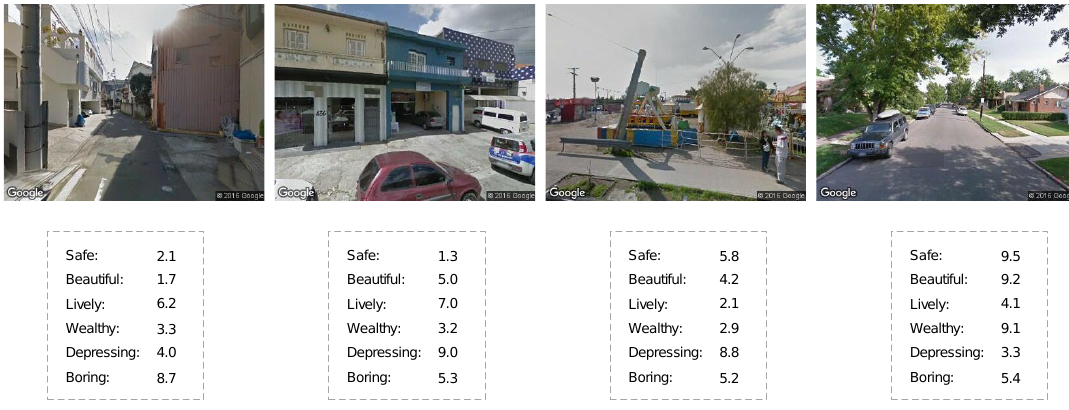
Figure 3. Image samples in the MIT Place Pulse dataset with their perceptual score along the six